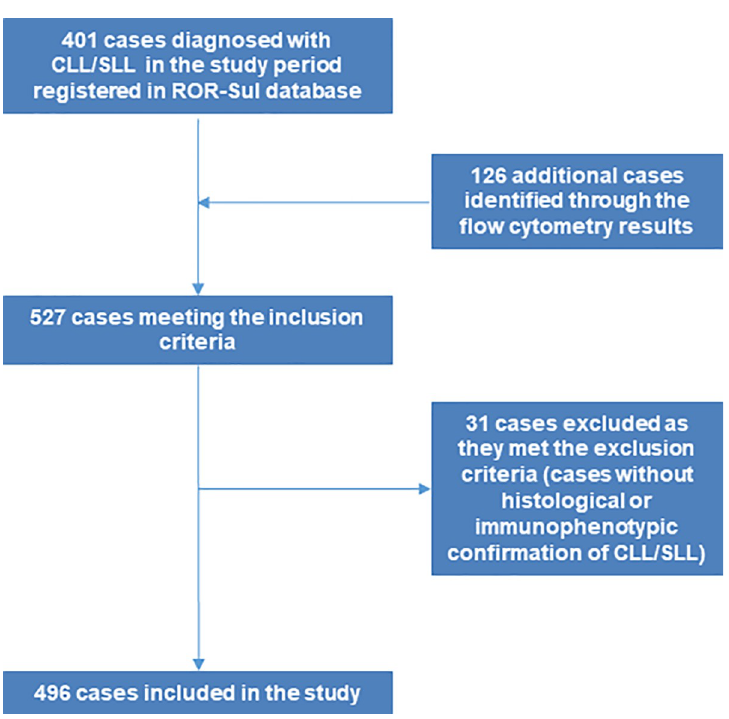
Fig 1. Flowchart for the identification of CLL/SLL cases diagnosed in 2013–2014 in ROR-Sul coverage